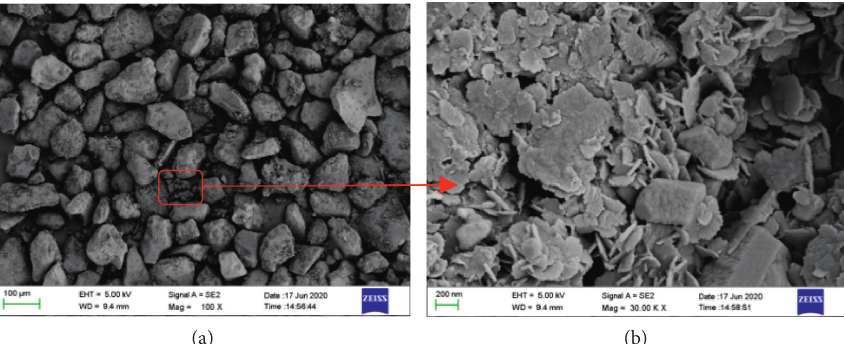
Figure 16: Microstructure of saline soils stabilised with Na 2 CO 3 and GGBS. (a) Close-up of specimen; (b) hydration product.